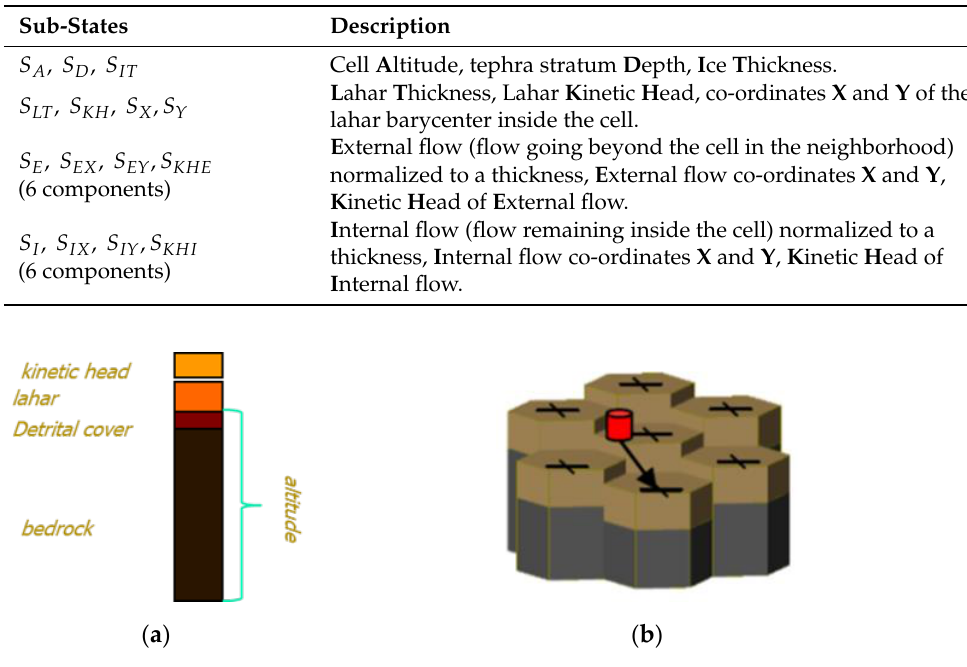
Figure 4. ( a ) Third dimension sub-states; ( b ) the outflow from the central cell to an adjacent cell.